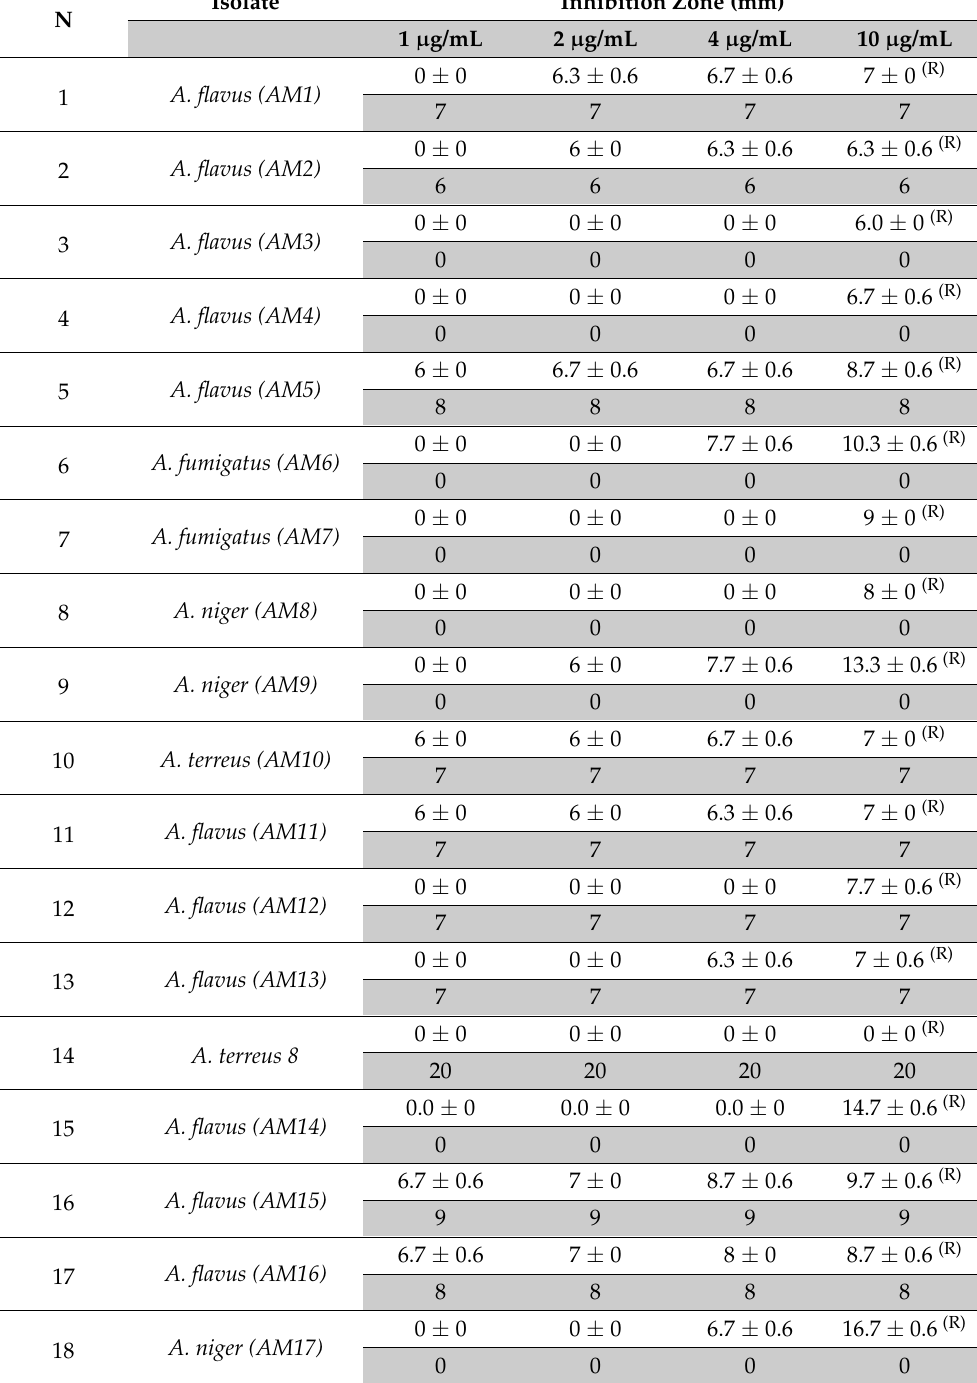
Table 3. Susceptibility of fungal species to different concentrations of Voriconazole (disc